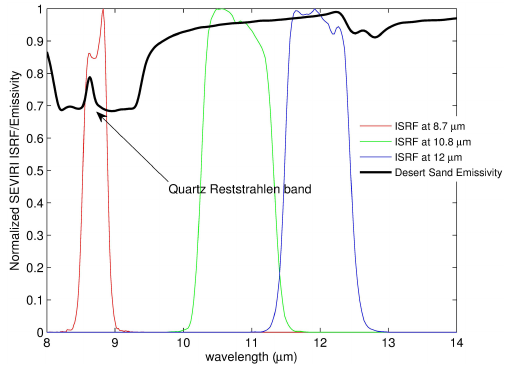
Figure 18. Typical desert sand emissivity (Baldridge et al., 2009) compared to the SEVIRI ISRF of the three atmospheric window channels.